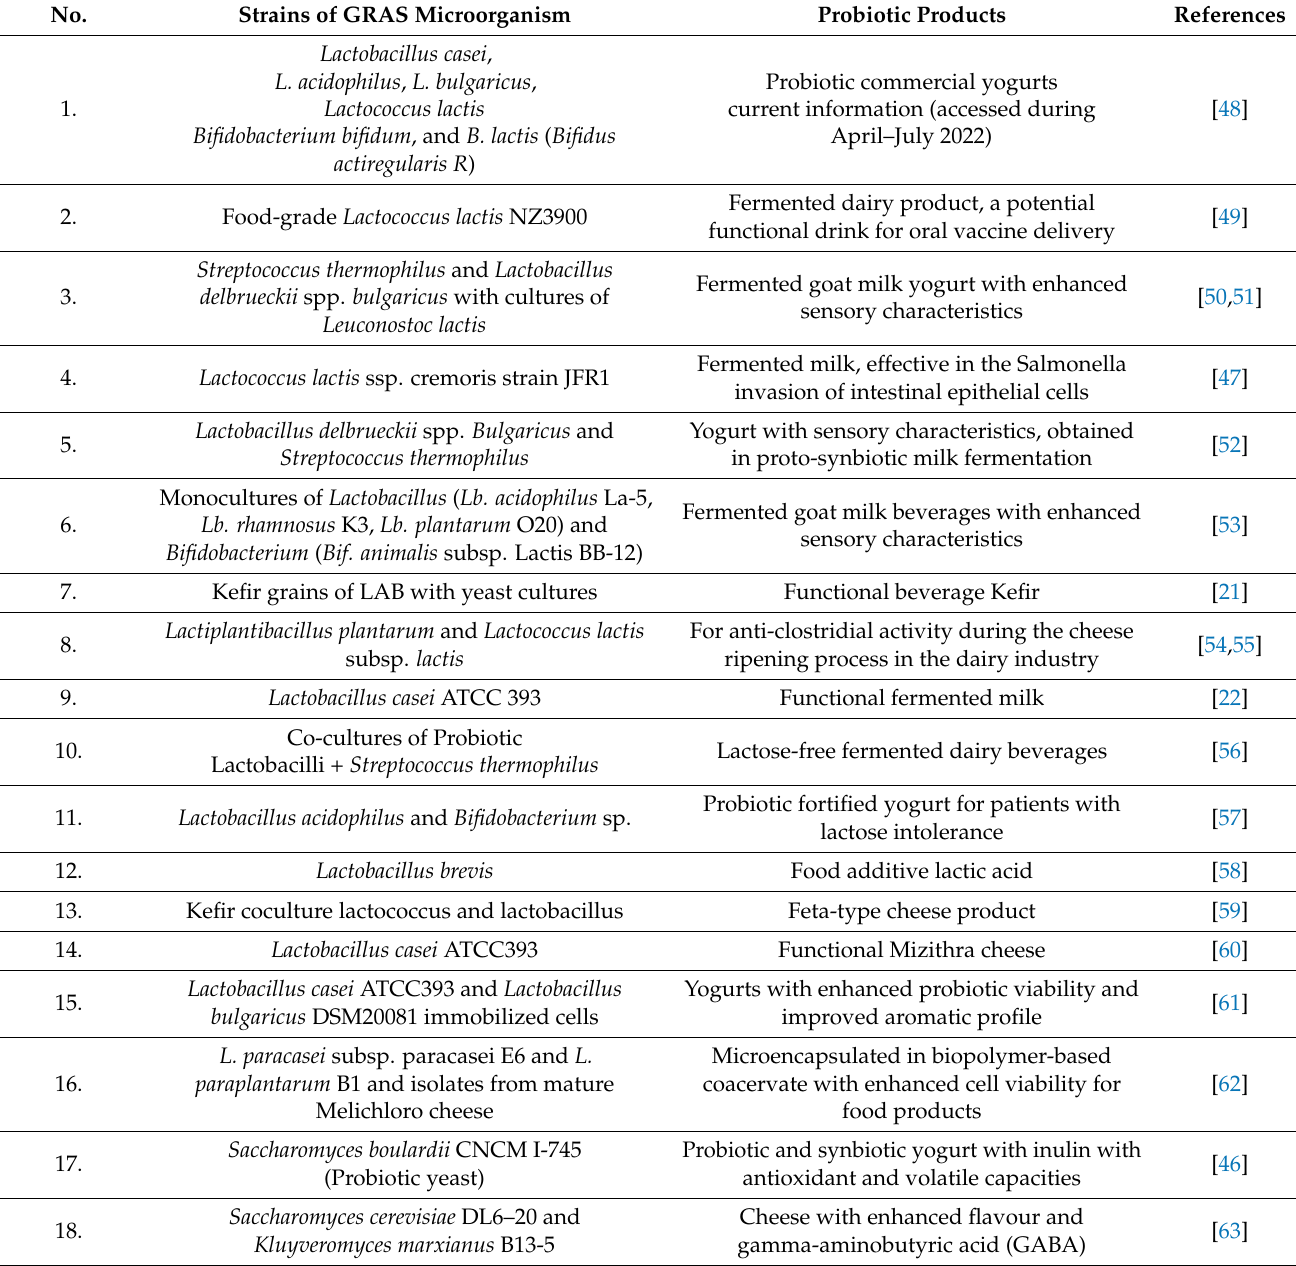
Table 1. A list of characterized microbial strains used in fermentation for the preparation of probiotic food and beverage